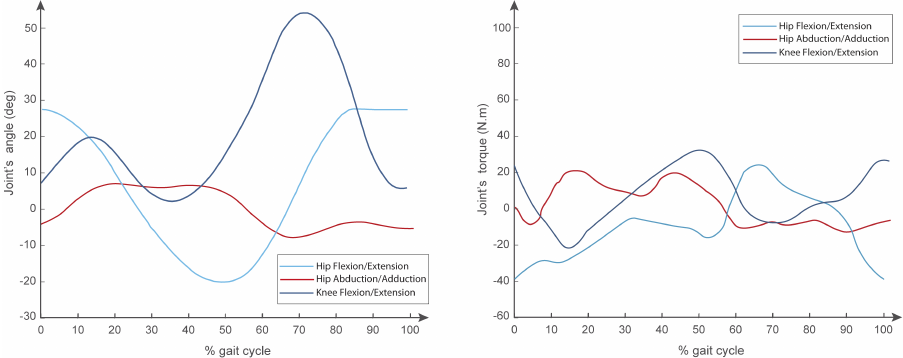
Figure 4. Joint’s angles for a gait cycle and the joint’s required